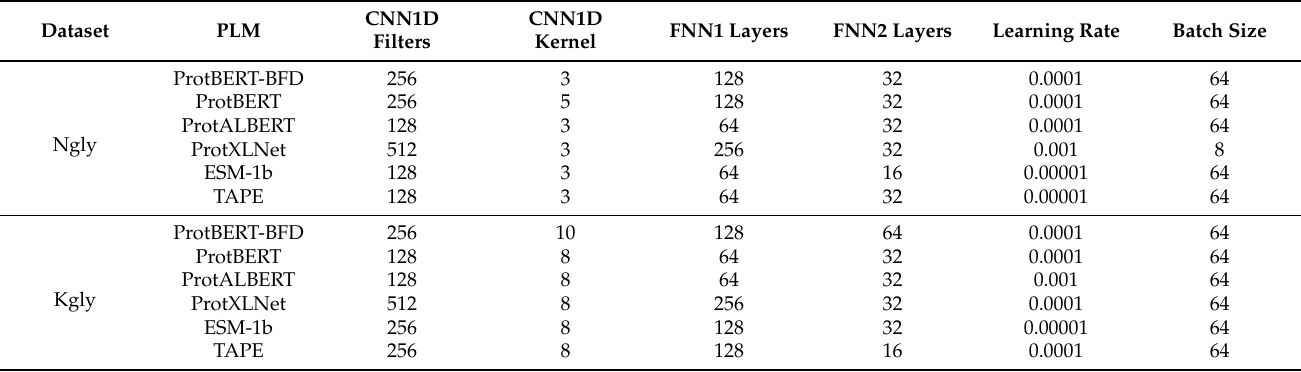
Table 3. The optimal hyperparameters for the CNN model are based on each PLMs using both Ngly and Kgly